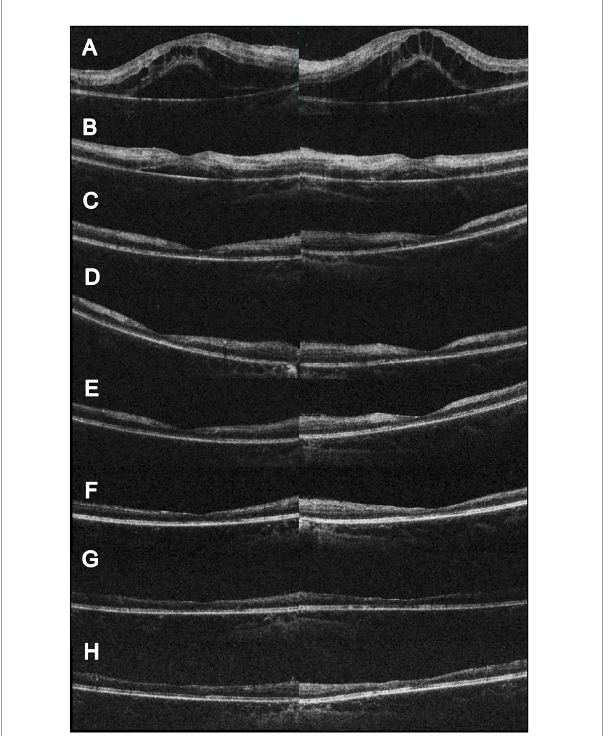
FIGURE2 Serial changes in OCT. (A) Initial OCT showed profound macular edema with combine intraretinal and subretinal fluid. (B) Two weeks after initial visit, partial resolution of the macular edema; however, hyperreflective change could be noted at the inner and middle retinal layers. The visual acuity was 0.1 (right) and 0.05 (left). (C) Eleven weeks after initial visit, complete resolution of the macular edema. CFT 156 µ m (right) and 147 µ m (left). The visual acuity was 0.05 (right) and counting finger 30 cm (left). (D) Seventeen weeks after initial visit and 4 weeks following HBOT. Slightly reduce hyperreflectivity at the left eye could be noted. The visual acuity was 0.1 (both). (E) Twenty-one weeks after initial visit and 8 weeks following HBOT. Extensive retinal thinning with ellipsoid zone loss was noted. The visual acuity was 0.16 (both). (F) Twenty-eight weeks after initial visit and 15 weeks following HBOT. Reduced inner retinal thinning was noted. The visual acuity was 0.16 (right) and 0.2 (left). (G) Forty-three weeks after initial visit and 30 weeks following HBOT. Reduced inner retinal thinning was noted. The visual acuity was 0.05 (right) and 0.16 (left). (H) Sixty weeks after initial visit and 47 weeks following HBOT. Reduced inner retinal thinning was noted. The visual acuity was 0.1 (right) and 0.16